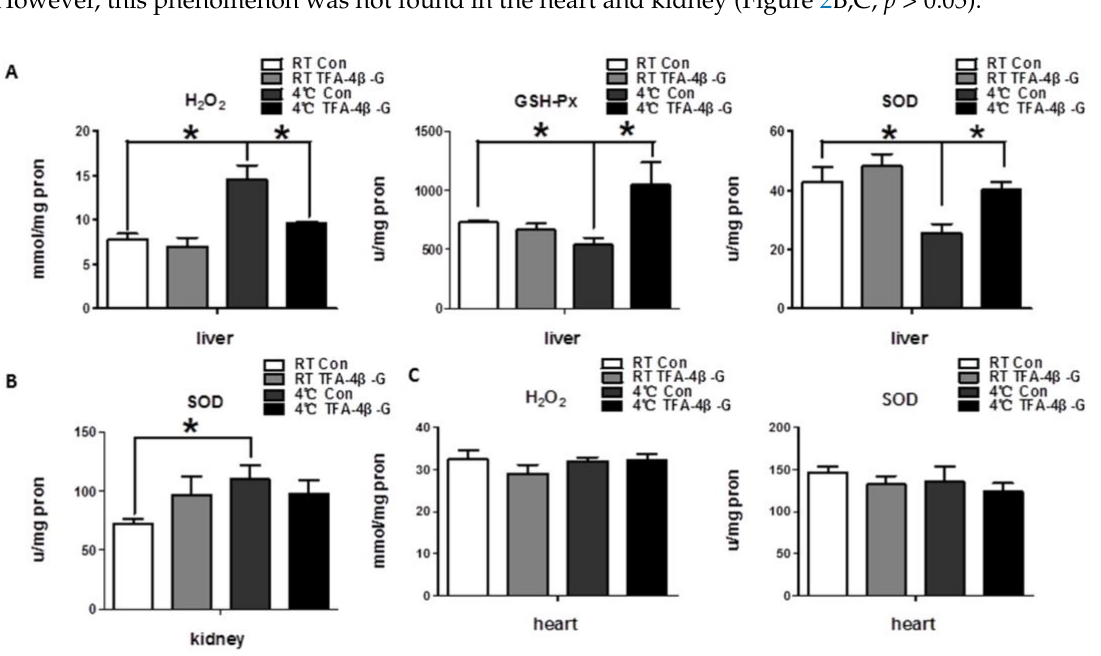
Figure 2. Trans -ferulic acid-4- β -glucoside alleviates cold-induced oxidative stress in liver. ( A ) The index related to oxidative stress in liver ( n = 4); ( B ) the index related to oxidative stress in kidney ( n = 4); ( C ) the index related to oxidative stress in heart ( n = 4). * p < 0.05 as indicated.